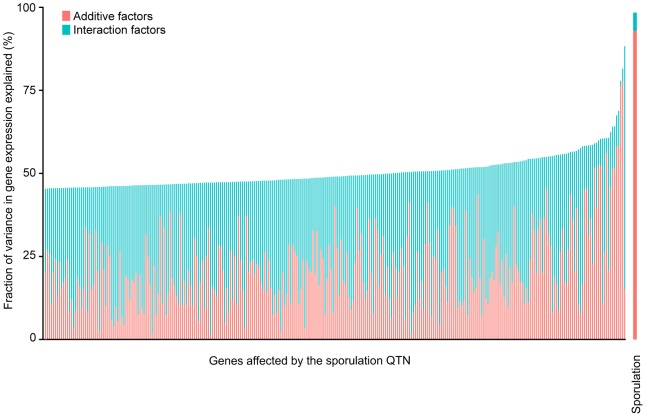
Fraction (%) of sporulation and gene expression variance explained by main (pink) and interaction effects (cyan) of all four sporulation QTN together.Only the 289 ORFs with significant gene expression models are shown. The ORFs are ordered by fraction of total variance explained in the full model. Each column represents the amount of variation in gene expression explained for a given ORF. The last column represents the fraction of sporulation efficiency variance explained by the QTN. Only the significant ANOVA factors in both the sporulation efficiency and gene expression models were considered to calculate the fraction of variance explained by main and interaction effects (f-statistic p-value<0.1).